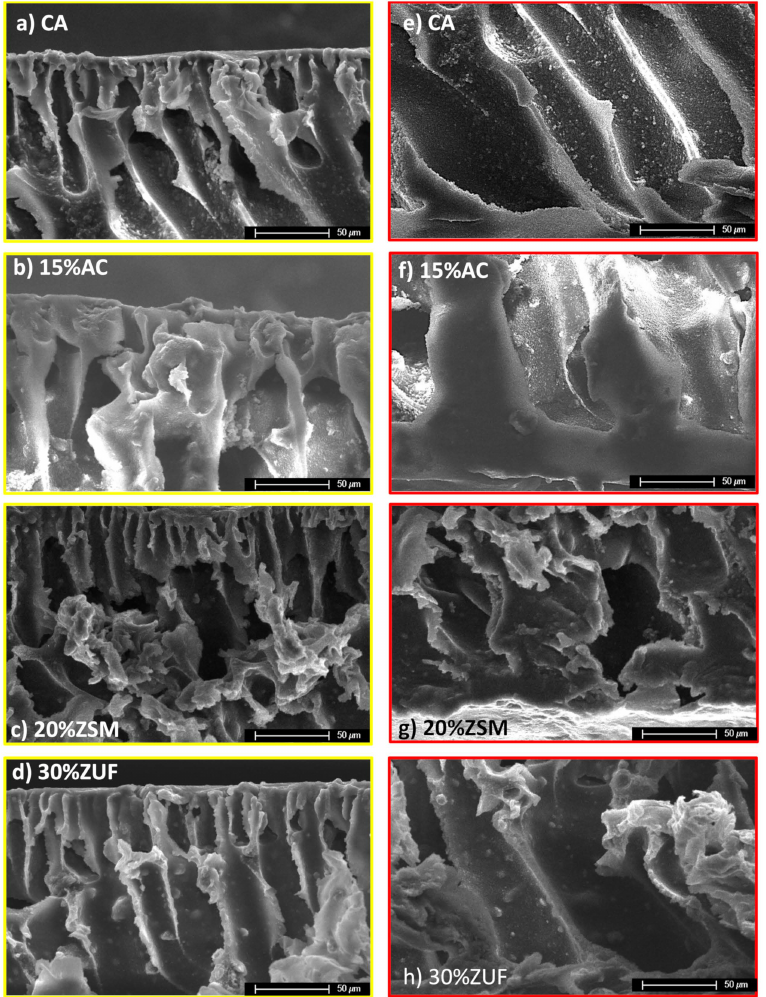
Figure 3. SEM images of pure CA membrane ( a ) top and ( e ) bottom; MMMA containing 15% of AC: ( b ) top and ( f ) bottom; MMMA containing 20% of ZSM-5: ( c ) top and ( g ) bottom; MMMA containing 30% of ZUF: ( d ) top and ( h )